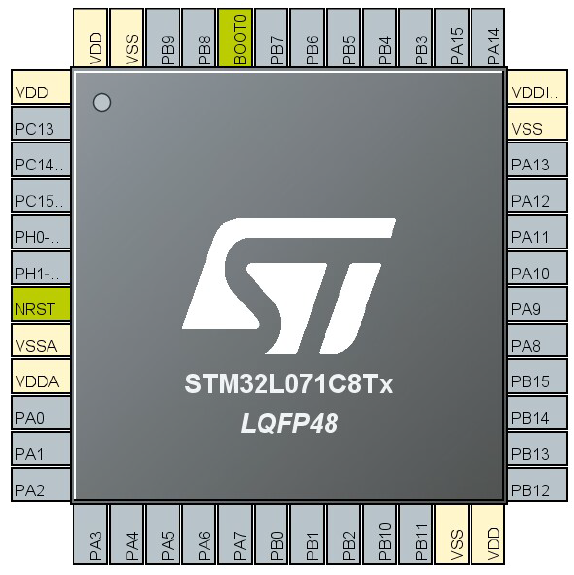
Figure 8. STM32L053C8T6 pin diagram.